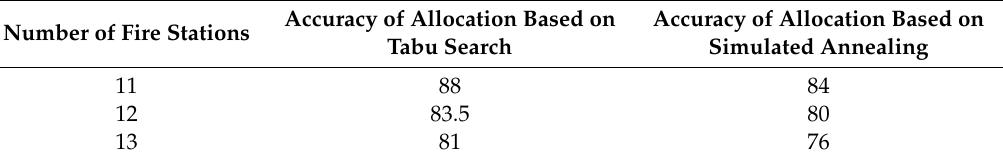
Table 18. Comparison of the accuracy of allocation results.